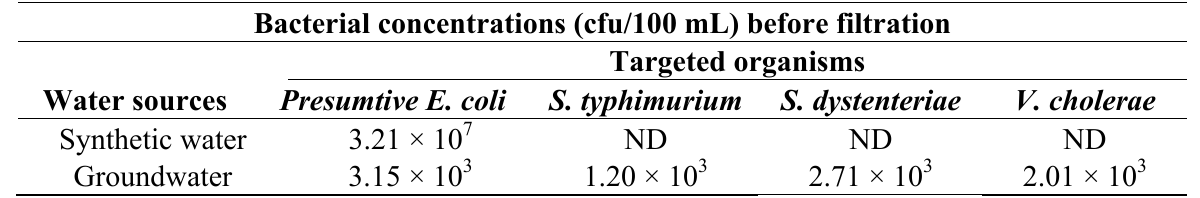
Table 1. Microbiological quality of spiked water sources before treatment.